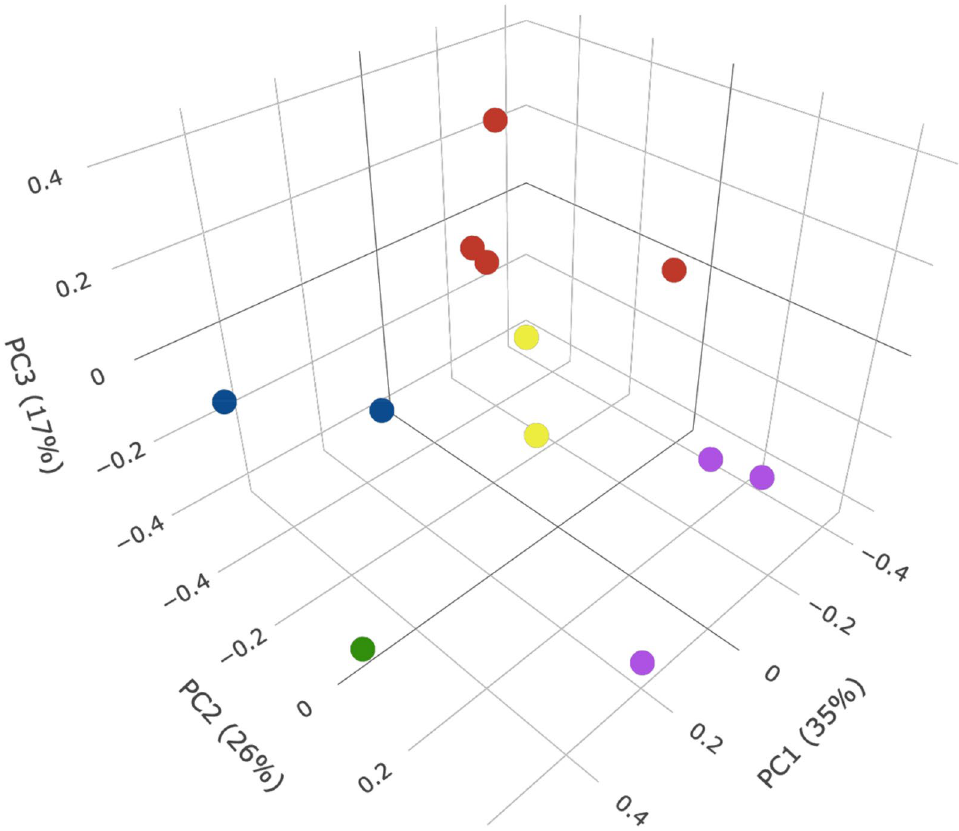
Figure 3. Cluster analysis of L. ( V. ) braziliensis clinical isolates. Principal components analysis (PCA) was performed to group clinical isolates based on the normalized quantitative variables. Each point represents the first three principal components of a clinical isolate. The points are colored according to the cluster they belong to, C1 (blue filled circle): NR6 and R3; C2 (red filled circle): R1, R3, NR5 and NR7; C3 (green filled circle): NR3; C4 (violet filled circle): NR2, R2 and R4; C5 (yellow filled circle): NR1 and NR4. The figure was generated using R version